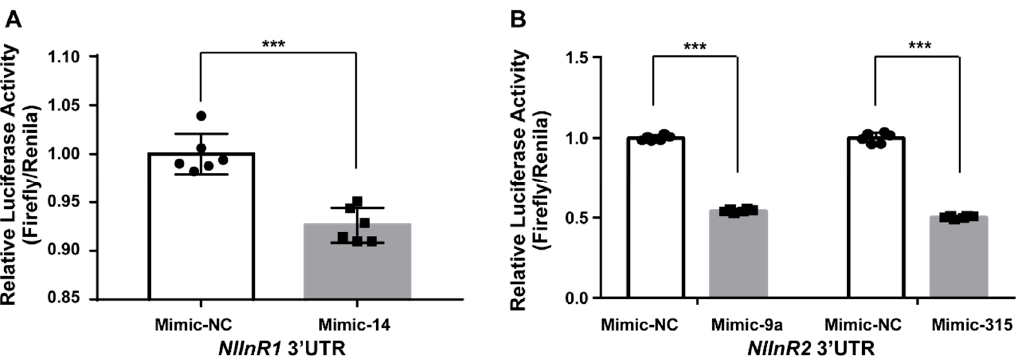
Figure 4. Sankey diagrams of miRNAs, target genes and enriched pathways predicted by more than two algorithms (miRanda, TargetScan, RNAhybrid and PITA). ALDH , Aldehyde dehydrogenase dimeric NADP preferring; JHE , Juvenile hormone esterase; Aldedh , Aldehyde dehydrogenase cytosolic 2-like; JHEH , Juvenile hormone epoxide hydrolase; JNK , Mitogen-activated protein kinase 8 / 9 / 10 (c-Jun N-terminal kinase); JUN , Transcription factor AP-1; JKK1 , Dual specificity mitogen-activated protein kinase kinase 7-like; JHAMT , Juvenile hormone-III synthase; FOHSDR , Farnesol dehydrogenase-like; PGRP , Peptidoglycan recognition protein; CYP15A1_C1 , Methyl farnesoate epoxidase-like; Br-C , Broad-complex core protein; Akt , Serine / threonine-specific protein kinase; Chico , Insulin receptor substrate; InR1 , Insulin receptor 1; Ilp2 , Insulin-like peptide; Lnk , SH2B adapter protein 1-like protein; InR2 , Insulin receptor 2; MAPK, Mitogen-activated protein kinase; Rheb , Ras homolog enriched in brain; Pten , Phosphatidylinositol-3,4,5-trisphosphate 3-phosphatase.